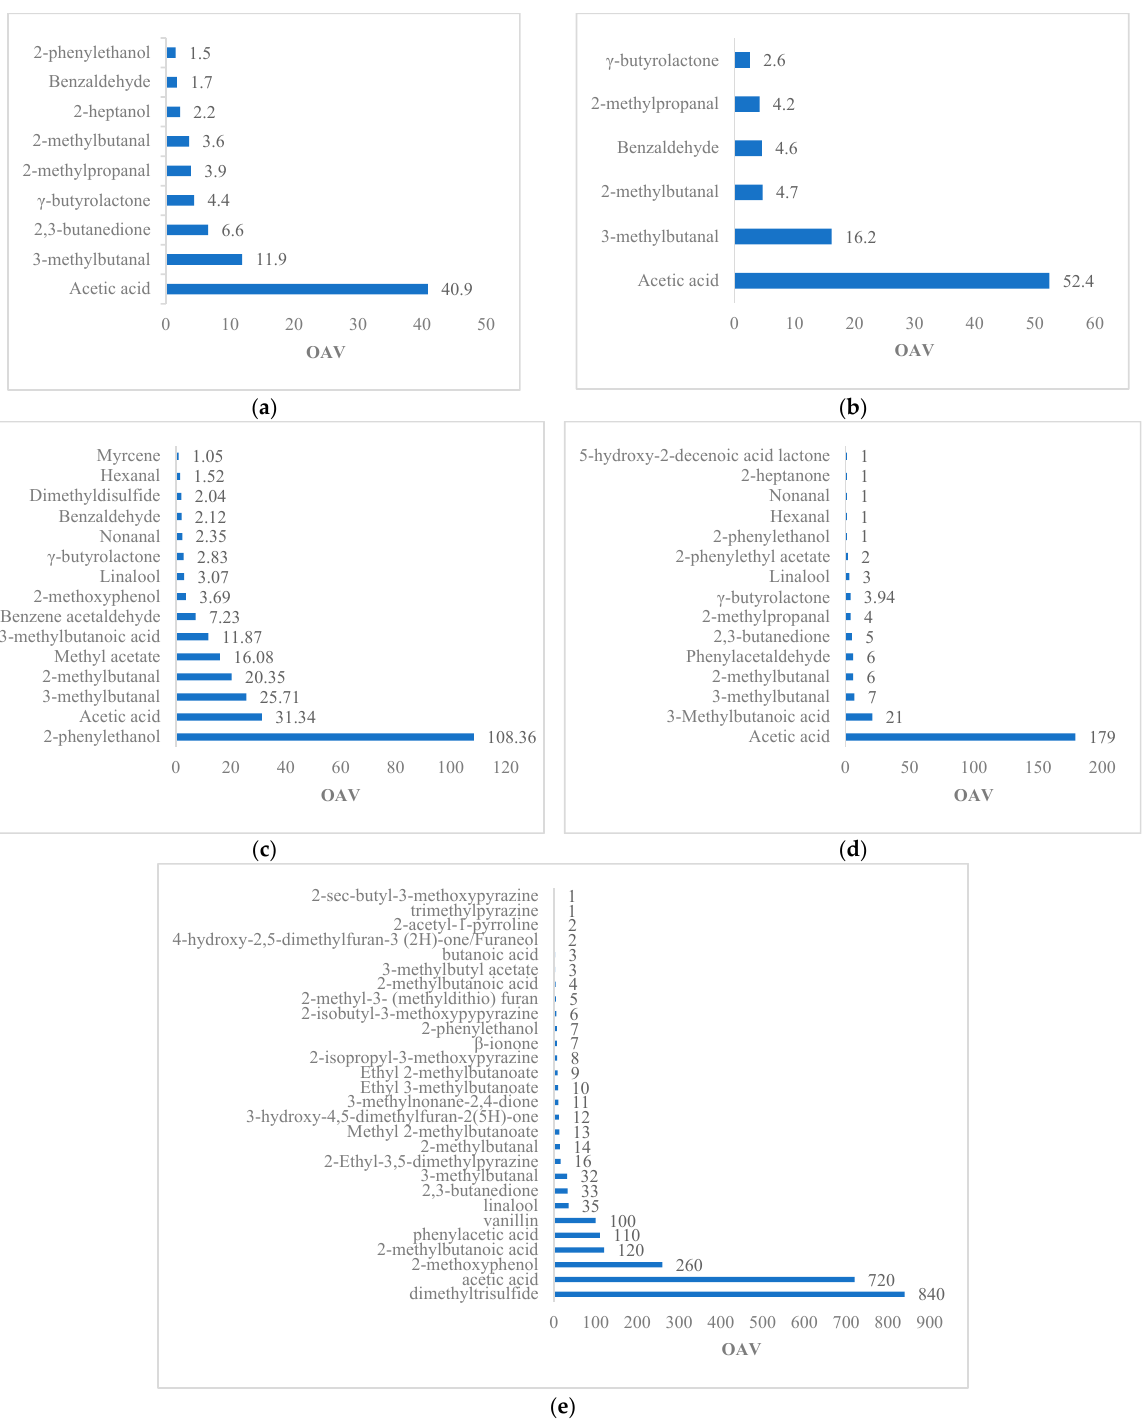
Figure 5. Studies of volatile compounds with OAV > 1 in dark chocolate determined by ( a ) [12] in chocolate from national cocoa beans, ( b ) [12] in chocolate from African cocoa beans, ( c ) [44] in chocolate from forastero cocoa beans, ( d ) [11] in Vietnamese cocoa beans and ( e ) [10] in commercial chocolate. The greater the availability of the compounds, the more complex the chocolate aroma is due to a wide volatile matrix. The studies in this paper show that acetic acid is the most abundant compound, and the rest of the compounds represent a mixture from different families (acids, alcohols, pyrans, aldehydes, esters, furans, and pyrazines). Table 6